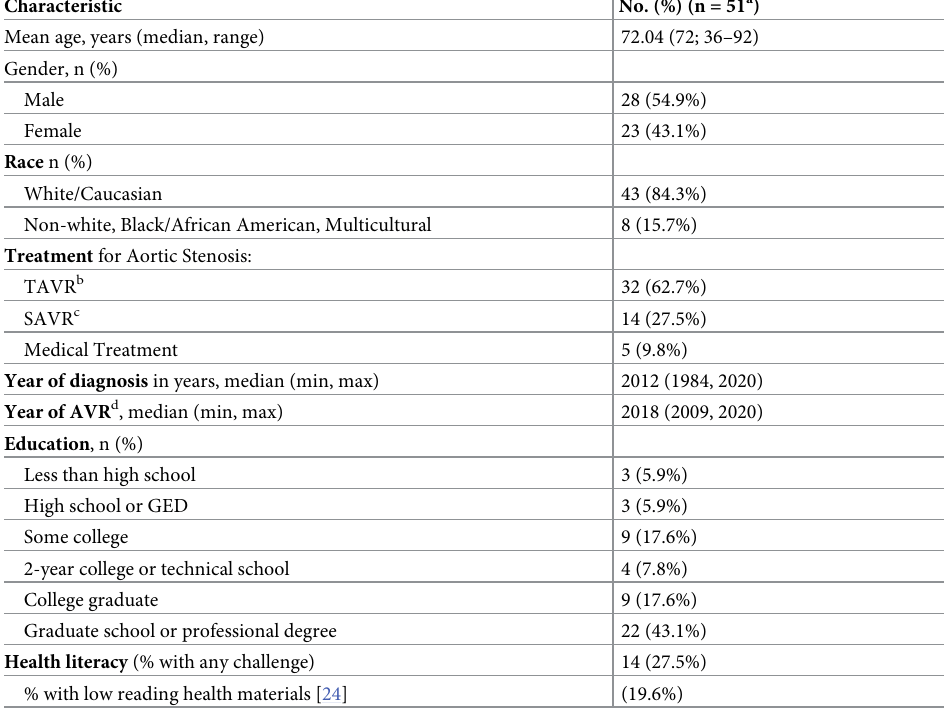
Table 1. Patient